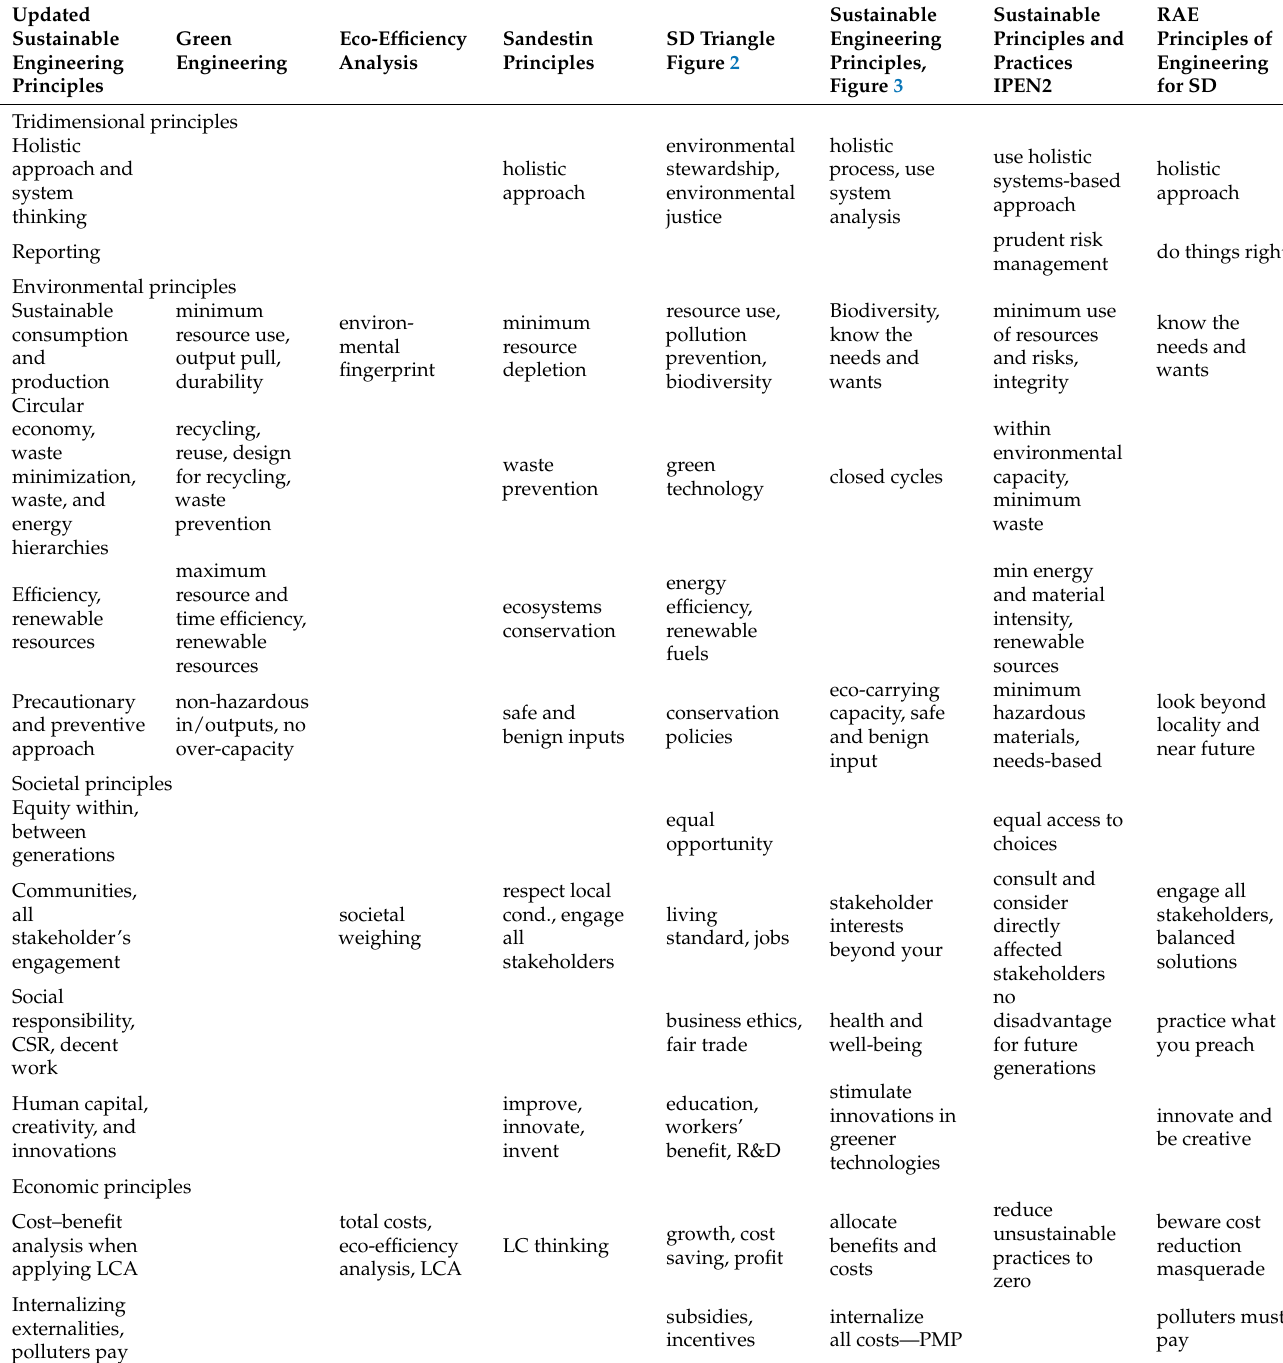
Table 5. Comparing the updated Sustainable Engineering Principles (SEP) with the ones described in Section